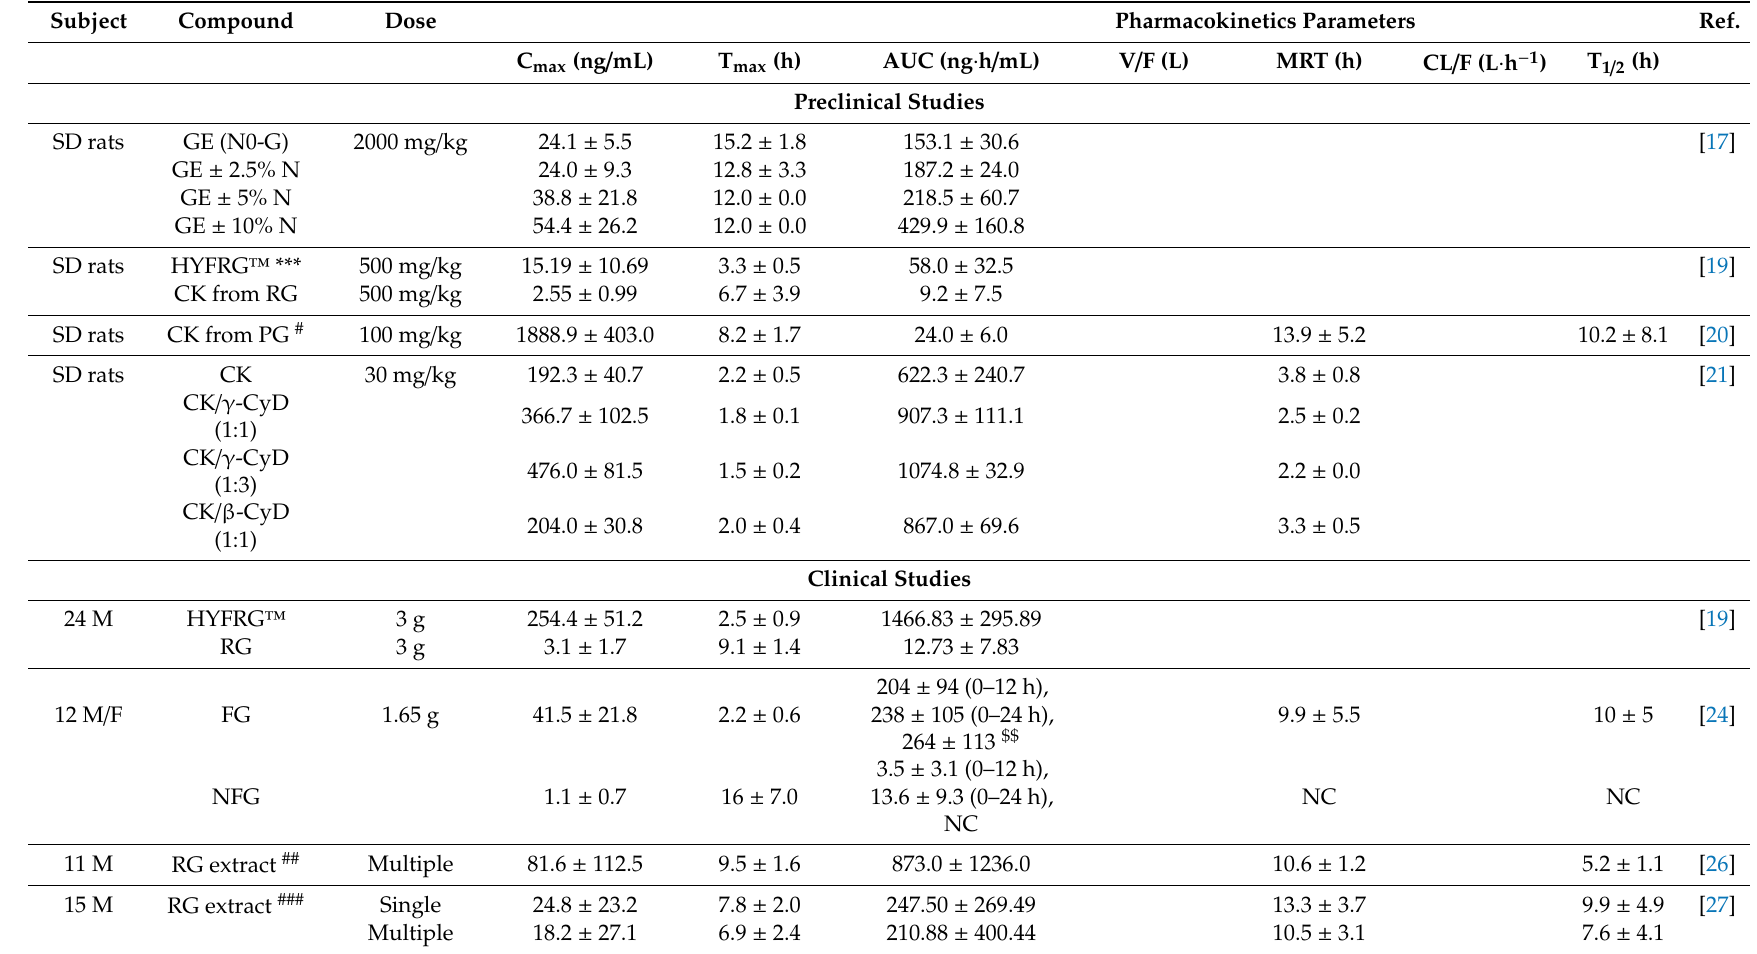
Table 1. Pharmacokinetics of CK and its